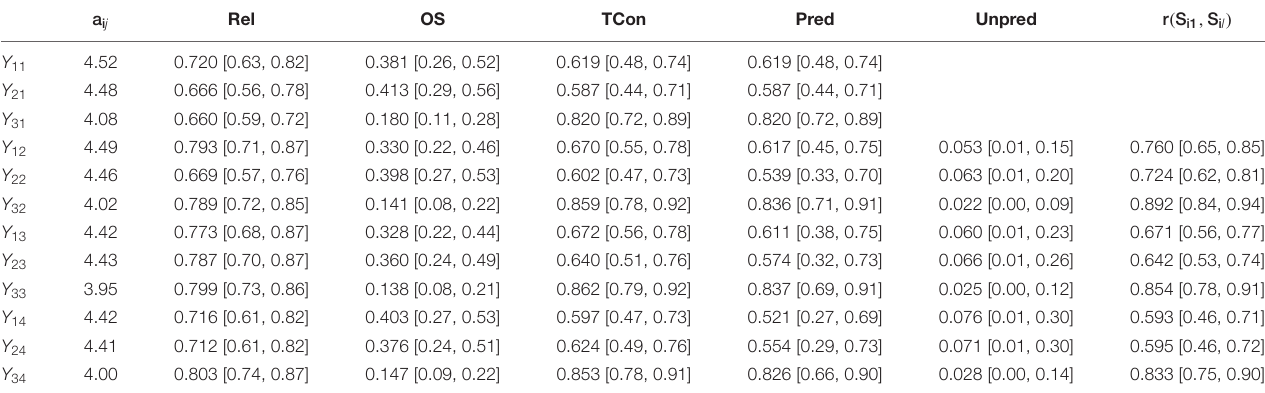
TABLE 1 | Results of the LST-AR model of targets’ attachment.